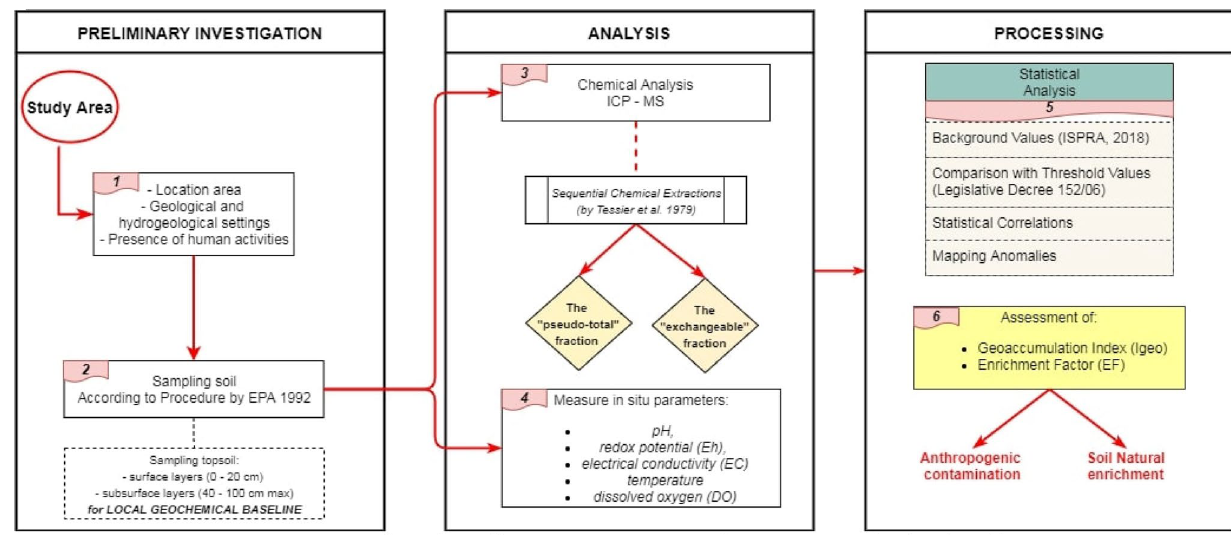
Fig. 1 Flow-sheet diagram to assess trace elements contamination in